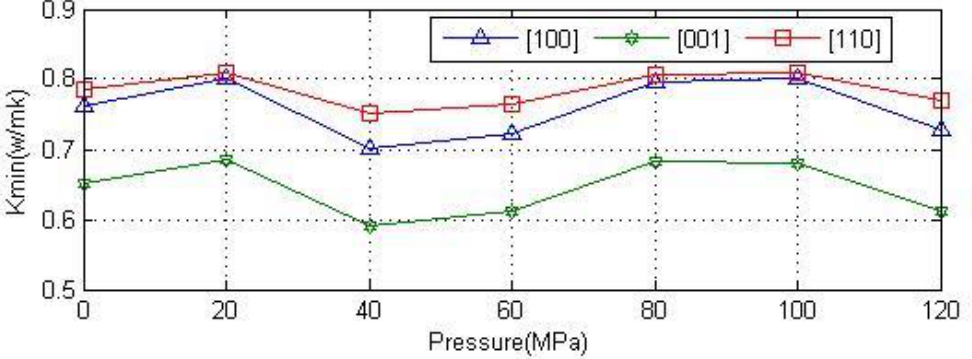
Figure 13. Relationship between the minimum thermal conductivity and pressure in the [100], [001] and [110] directions of anhydrite